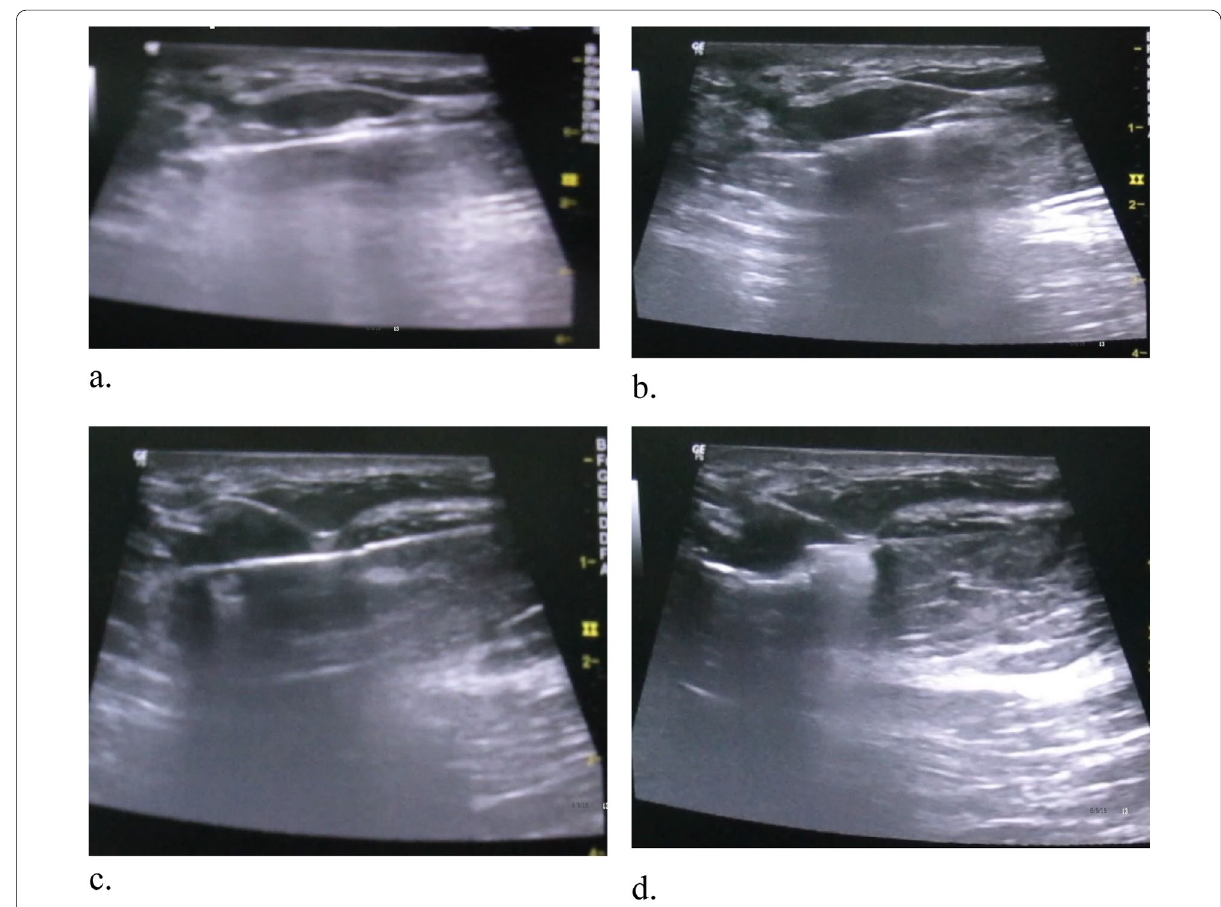
Fig. 2 a – d The process of VAB excision system suction of